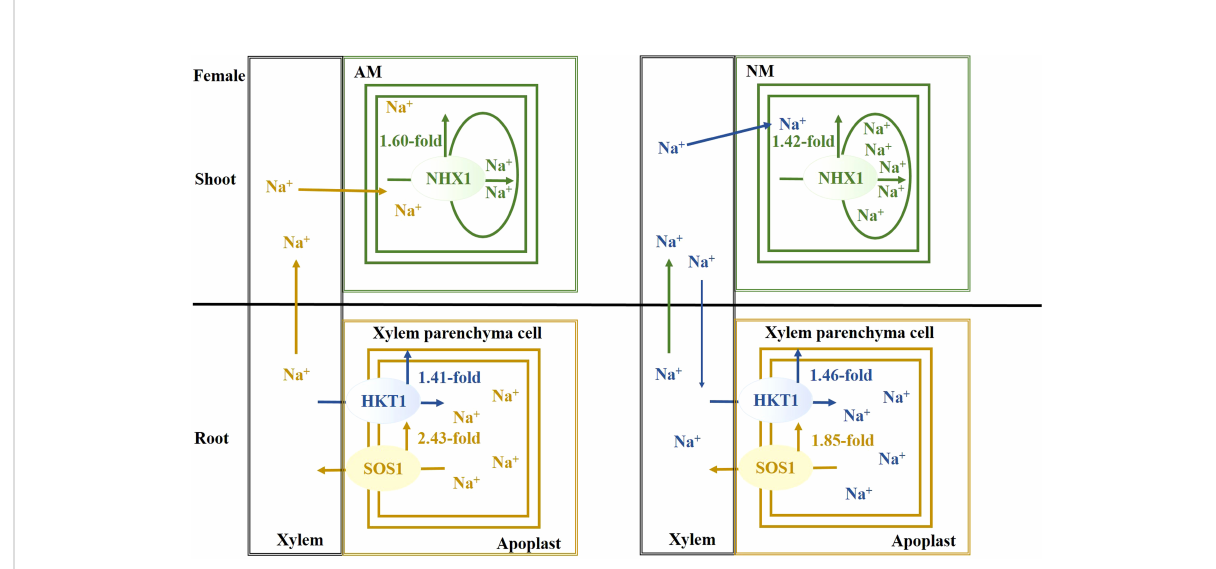
FIGURE 7 The schematic model for Na + transporters regulating Na + homeostasis for